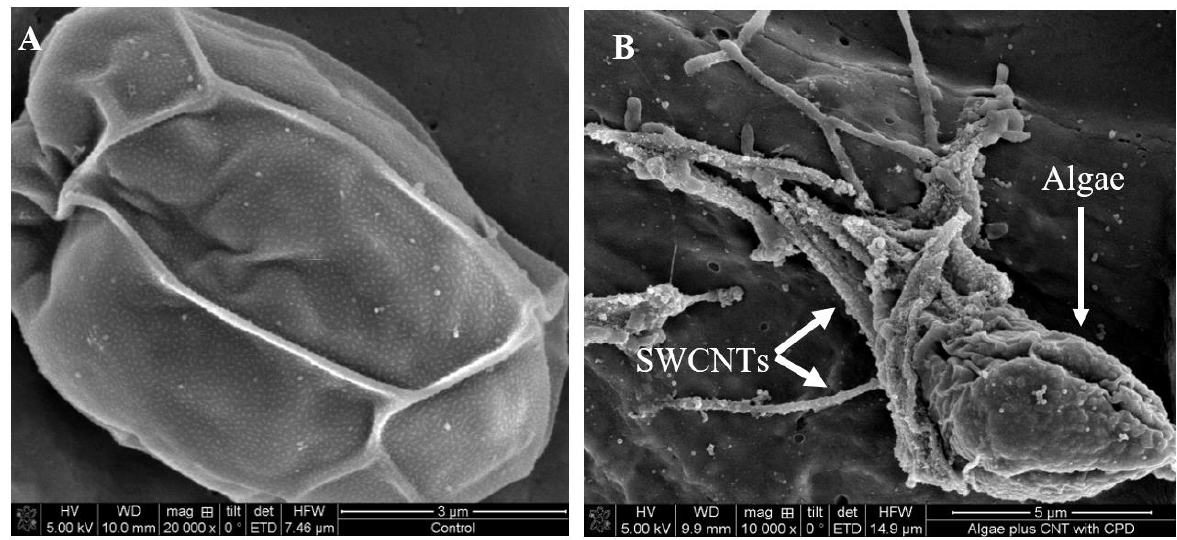
Figure 3. SEM images of T. suecica from control samples ( A ) and from culture medium containing final 500 µ g L − 1 SWCNTs ( B ); algae (appear surrounded by SWCNTs